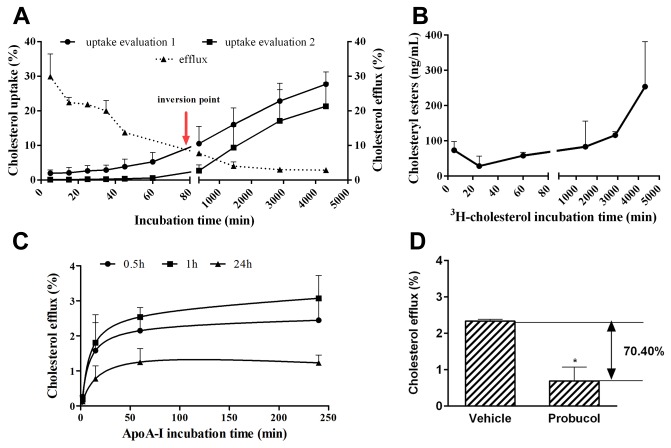
Kinetics of 3H-cholesterol transport in primary bovine mammary epithelial (MeBo) cells.
A: Comparative uptake (●) and efflux (▲) of 3H-cholesterol by MeBo cells growing as a monolayer in DMEM-F12 medium supplemented with 10% fetal bovine serum and 1% antibiotics/antimycotics. Cholesterol efflux was performed in the presence of 10µg/ml apoA-I (details see Materials and Methods). The cholesterol uptake was calculated either based on the amount of radiolabel disappearing from the medium (evaluation 1) or on the sum of the radiolabel measured in the cell lysate and efflux medium (evaluation 2). Both values were related to the initially loaded amounts of radiolabel that was defined as 100%. The arrow depicts the inversion point that is the incubation time where cholesterol uptake and efflux are in apparent equilibrium. It represents a threshold beyond which the availability of 3H-cholesterol for efflux becomes markedly reduced in favor of increasing intracellular compartmentalization.” B: Cholesteryl ester content of the cell lysate. Cholesteryl esters were measured with the Amplex Red® assay kit according to the manufacturer’s instructions. All experimental details were as described in section A. C: Time-dependent saturation curve of apoA-I mediated efflux. Cells were loaded with cholesterol for 0.5h (●), 1h (■), and 24h (▲). Details for cell equilibration were as described in section A. Please note that in contrast to Figure 4A, the background efflux measured in the absence of apoA-I was recorded, and subtracted from the total efflux measured in the presence of 10µg/ml of apoA-I. D: Regulation of apoA-I mediated efflux in MeBo cells. Cells were loaded with 3H-cholesterol (1µCi/ml) in complete DMEM-F12 medium supplemented with 10% fetal bovine serum and 1% antibiotics for 24h. Cells were equilibrated for 18h in serum-free medium followed by the efflux in the presence of apoA-I (10µg/ml) for 4h (see Materials and Methods for additional details). Cells were treated with probucol, an inhibitor of ABCA1, throughout the efflux time. All data are expressed as means ± SD of three independent experiments performed in triplicates.